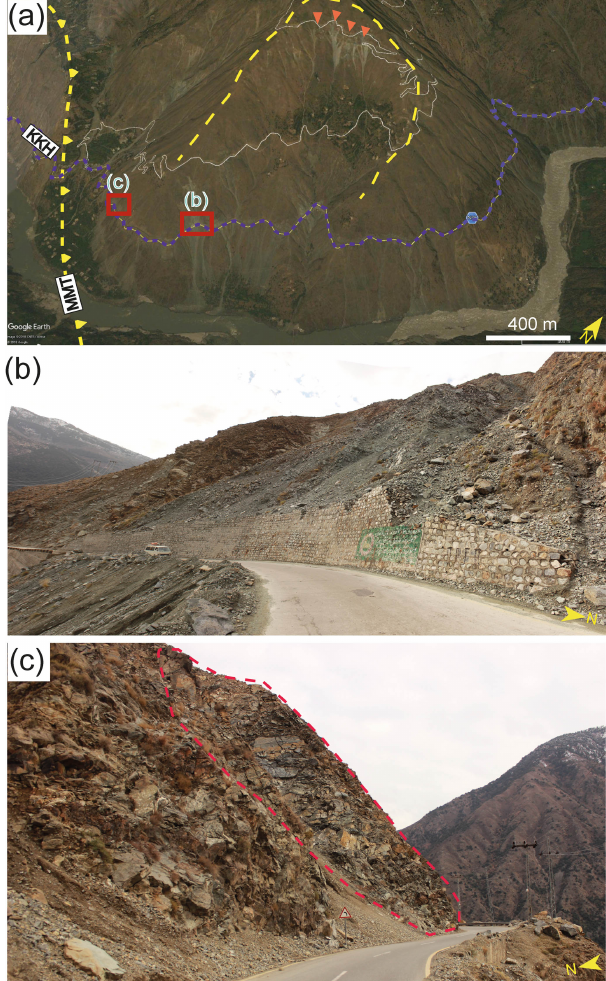
Figure 13. Very high landslide susceptibility along the KKH near Jijal (Google Earth, 2017a, Bing Maps) (for location see Box “X” in Fig. 12a). (a) Overview of 7.5km long small section of the highway northeast of Jijal: dotted black line represents MMT; dotted yellow line marks the boundary of catchment area (1.34km 2 ); pink arrows show ongoing rock/debris falls, which travel downslope along with water during heavy rainfall; gully erosion is prominent. (b) Famous “Shaitan Pari Slide” with partially damaged retaining wall. Reac- tivation of this slide is mostly during heavy rainfall. (c) Highly jointed rock mass is highly susceptible to rock/debris